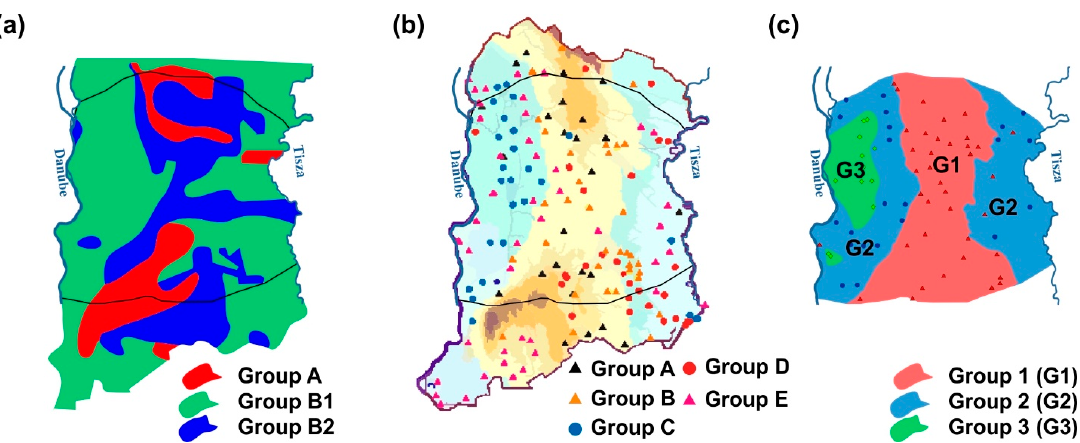
Figure 7. Schematic maps of the study area with the subareas delineated based on SGW levels. From 1976 to 2003 by Rakonczai and Geiger [40] ( a ) ; from 1970 to 2004 by Szalai et al. [38] ( b ) ; and the present study (1961 to 2010) ( c ). The black lines in panels ( a ) and ( b ) are the outline of the area presented in panel ( c